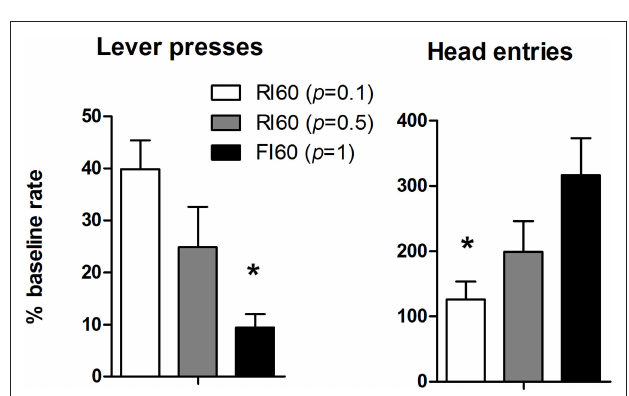
FIgure 4 | results from the second day of the omission test, expressed as a percentage of last training session. The left panel shows lever presses. The right panel shows the head entries into the food